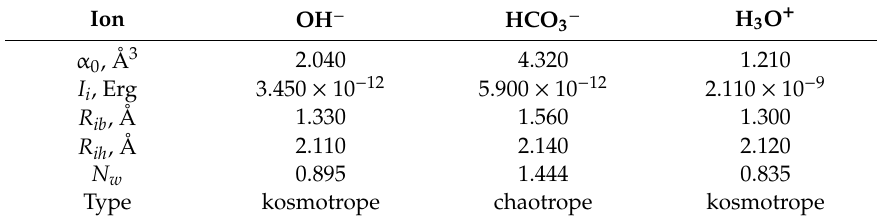
Table 3. Polarizability, ionization potential, bare radius, hydration radius [65,66], ensemble of N w surface water molecules (see Equation (A11)) and type of ion for OH − , HCO 3 − and H 3 O + ions.